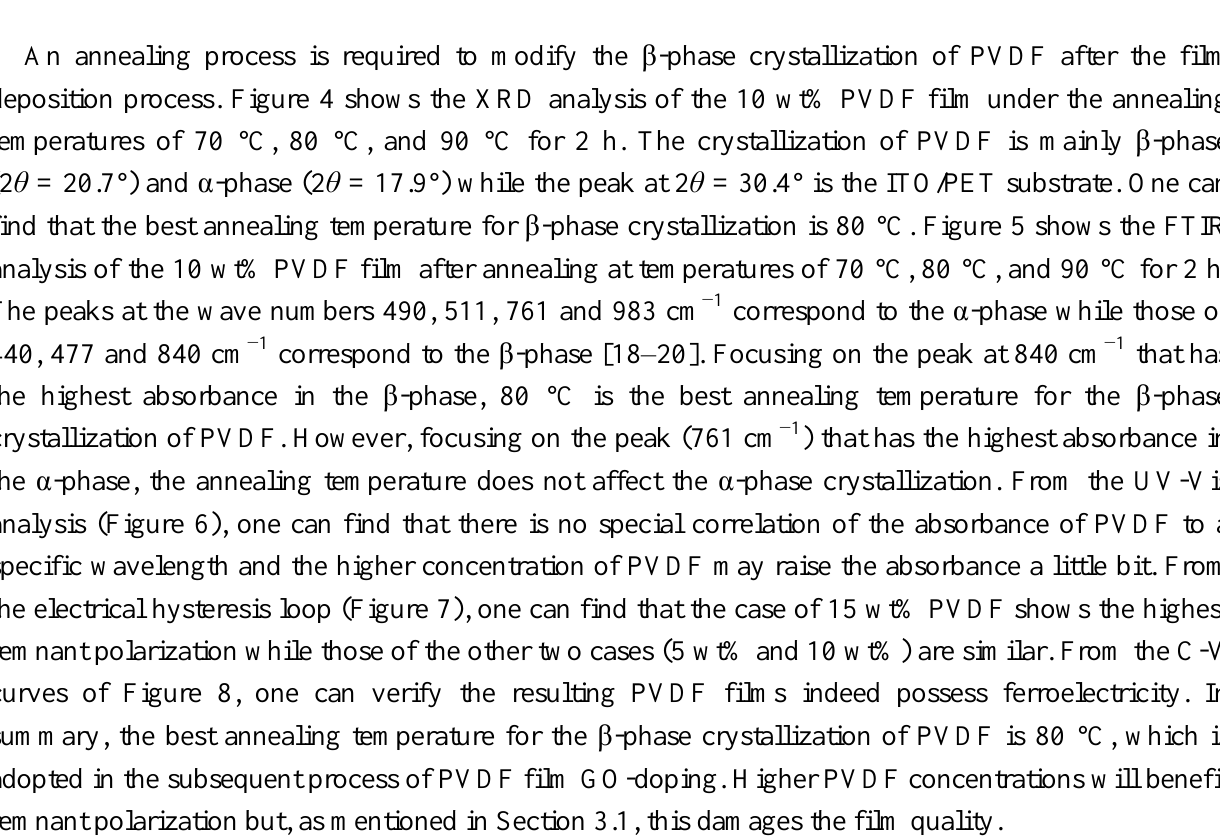
Figure 4. The XRD analysis of 10 wt% PVDF film under different annealing temperatures.